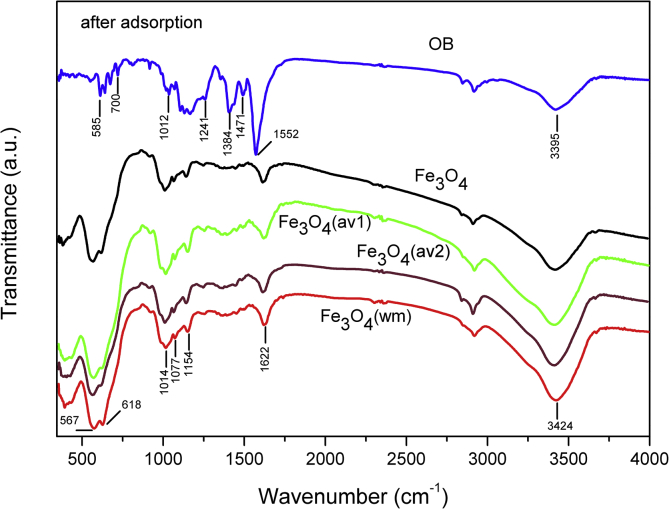
FTIR spectra of OB dye and ST-coated Fe3O4 NPs after dye adsorption.